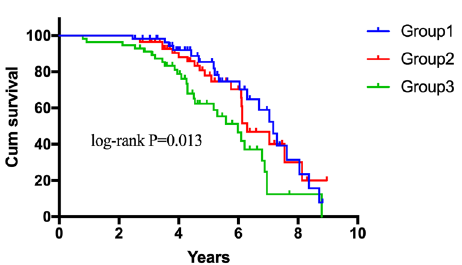
Fig. 2 Comparison of survival between the three groups accord- ing to NLR tertiles. The numbers of group 1, group 2, and group 3 were 56, 57, and 56, respectively. Kaplan – Meier survival analysis and log-rank tests were performed (log-rank p = 0.013). NLR: neutrophil- to-lymphocyte ratio.